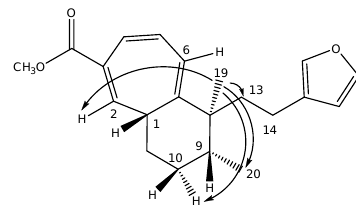
Figure 7. Selected NOE correlations for compound 3 .